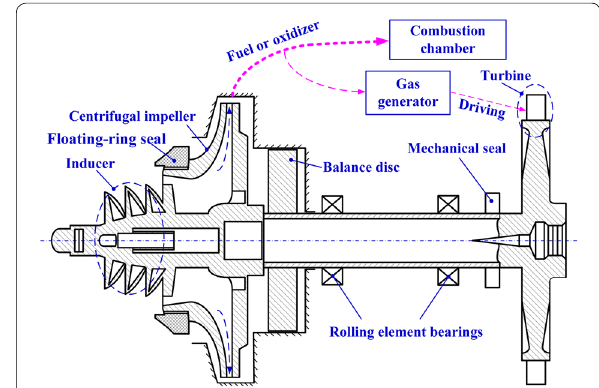
Figure 2 Typical structure of the liquid rocket turbopump rotor